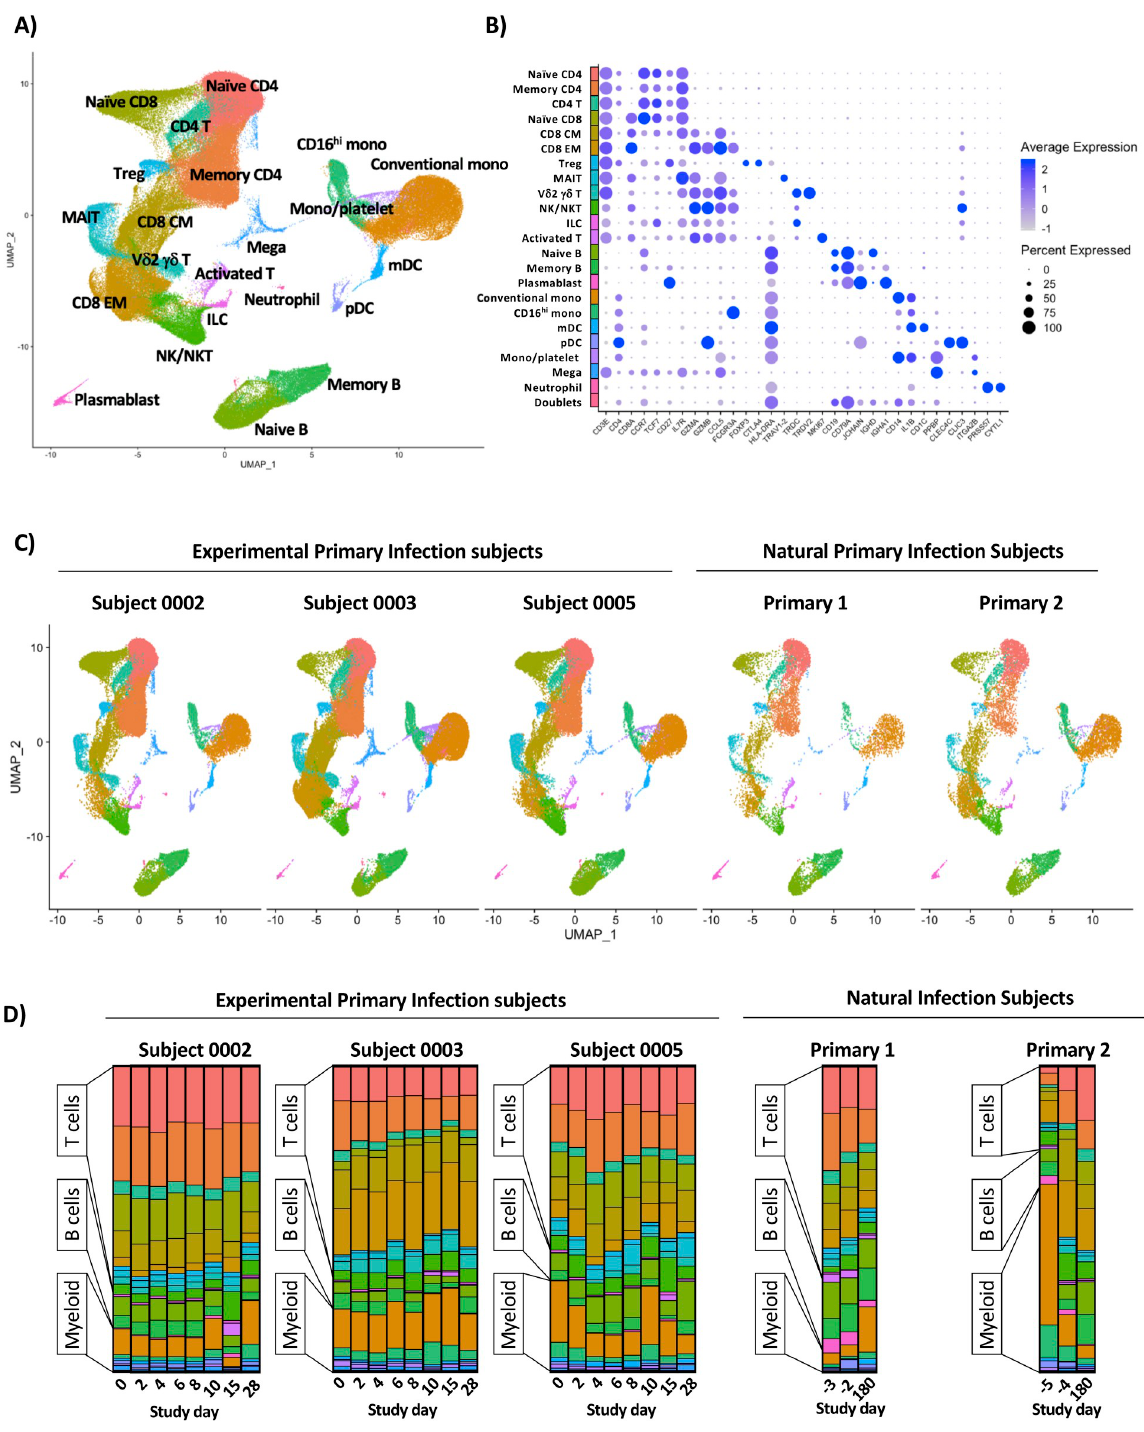
Fig 2. Annotation and quantification of major leukocyte populations following experimental or natural primary DENV-1 infection. A) Integrated UMAP projection of scRNAseq data from all annotated leukocyte populations derived from all experimental primary DENV-1 infection subjects (n = 3, 8 time points per subject) and natural primary DENV-1 infection subjects (n = 2, 3 time points per subject). B) Expression of key linage defining gene products across all annotated leukocyte populations captured in this analysis. C) Integrated UMAP projection of all annotated leukocyte populations split by subject, including all time points. D) Relative population abundance in all subjects split by time point.